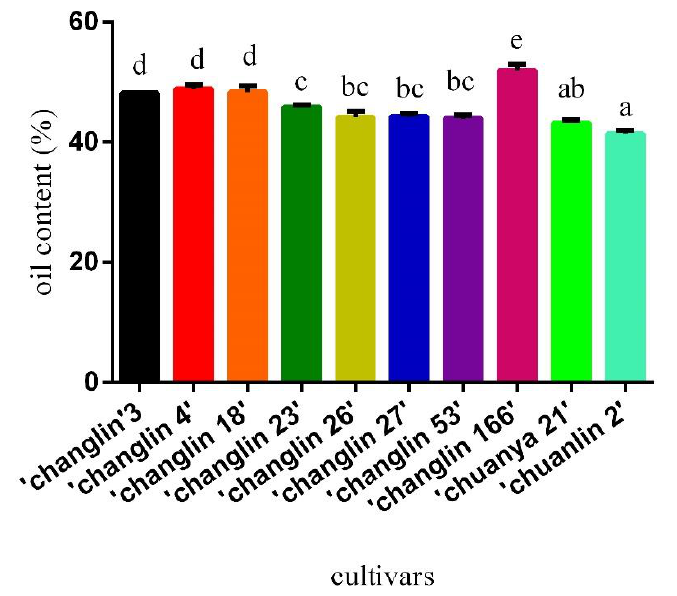
Figure 1. The oil content of C. oleifera oil of ten cultivars. The data are expressed as the mean ± standard deviations, n = 3. Different letters indicate significantly different values, p < 0.05. Table 1. Acid, peroxide and iodine values in C. oleifera oil from ten cultivars. Acid Value